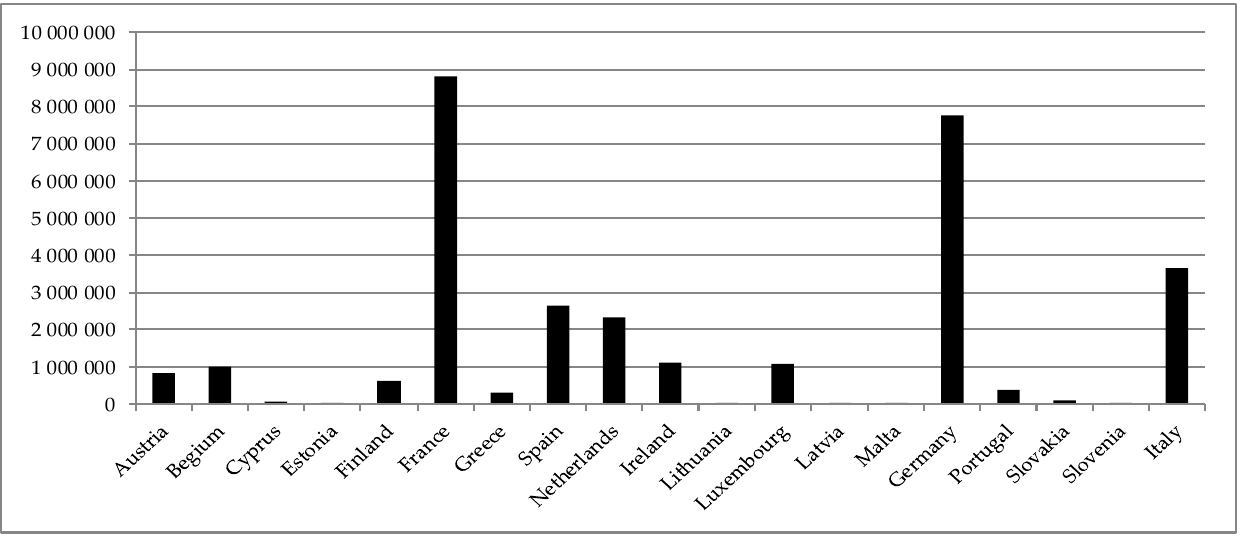
Figure 1. Total assets of the euro area banking sectors (at the end of 2018)—in mln EUR (source: own work based on the European Banking Federation data).